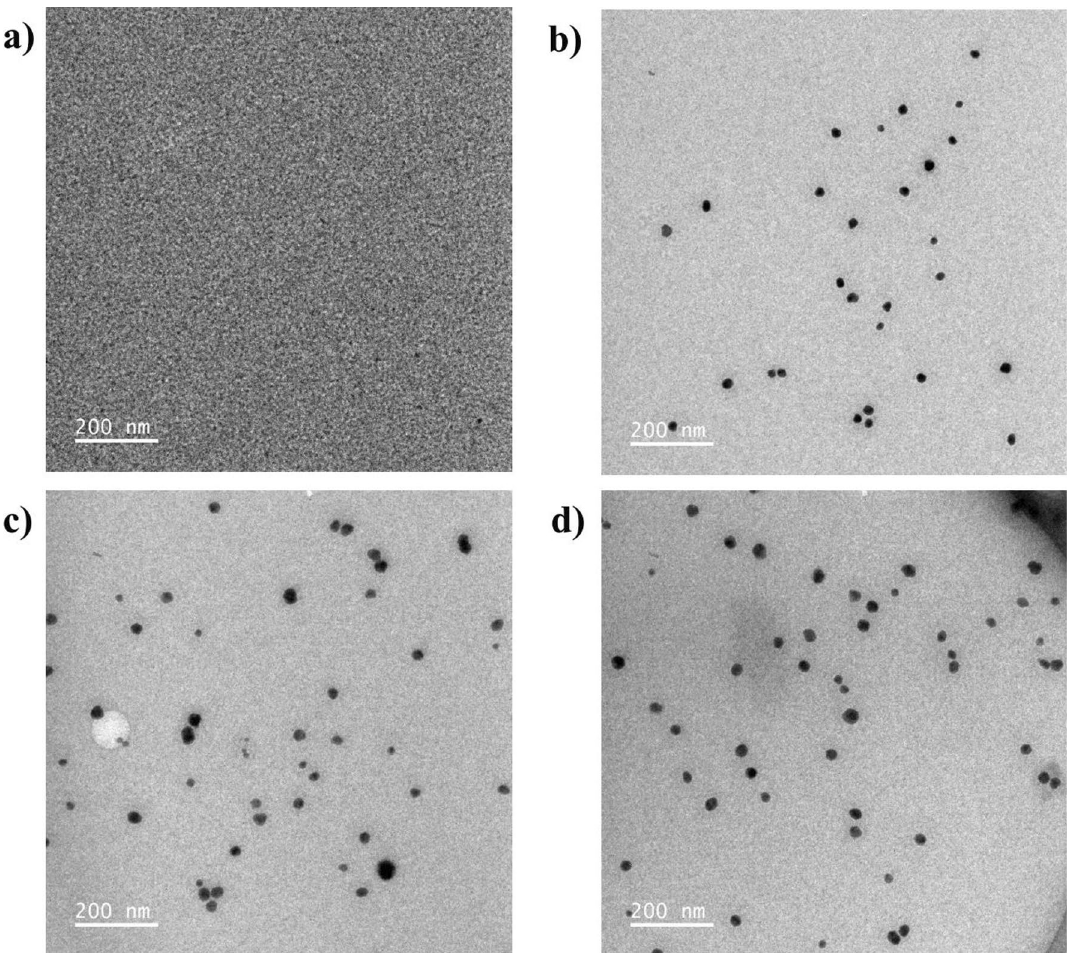
Figure 2. TEM micrographs of AgNPs at different AgNO 3 concentrations: ( a ) 0 mM, ( b ) 50 mM, ( c ) 100 mM, and ( d ) 150